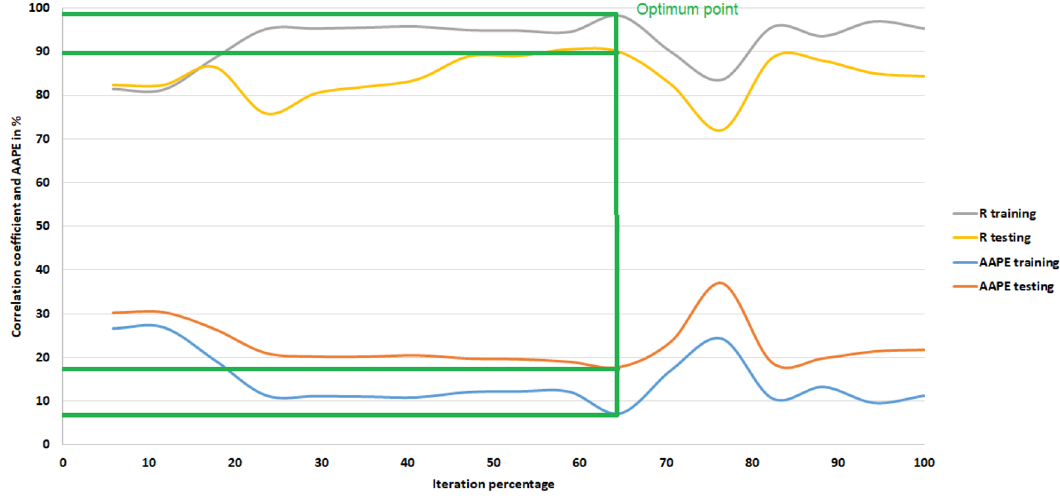
Fig. 9 Results of different iteration in